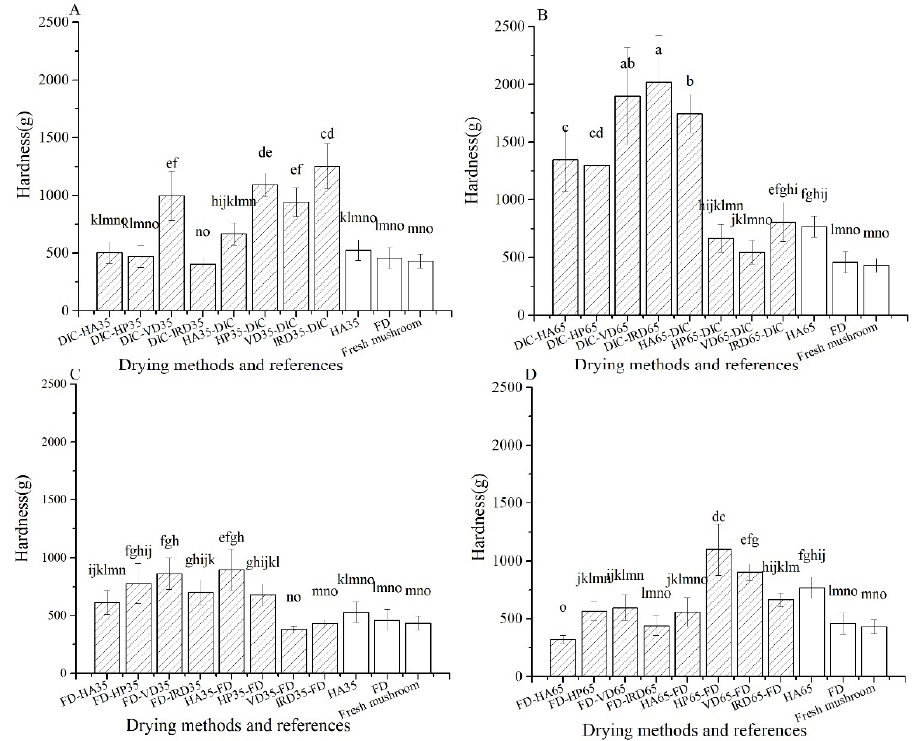
Figure 6. Harness of rehydrated mushrooms with different drying methods ( shown in Table